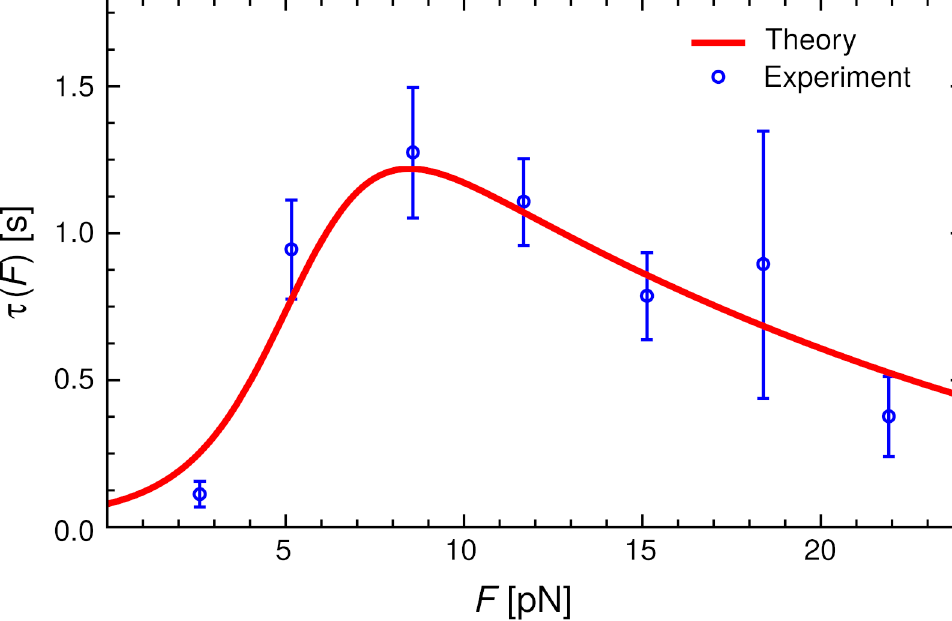
Fig 3. Experimental mean bond lifetime τ ( F )versus force F (symbols) from Ref. [11] compared to the theoretical model with best-fit parameters from Table 1